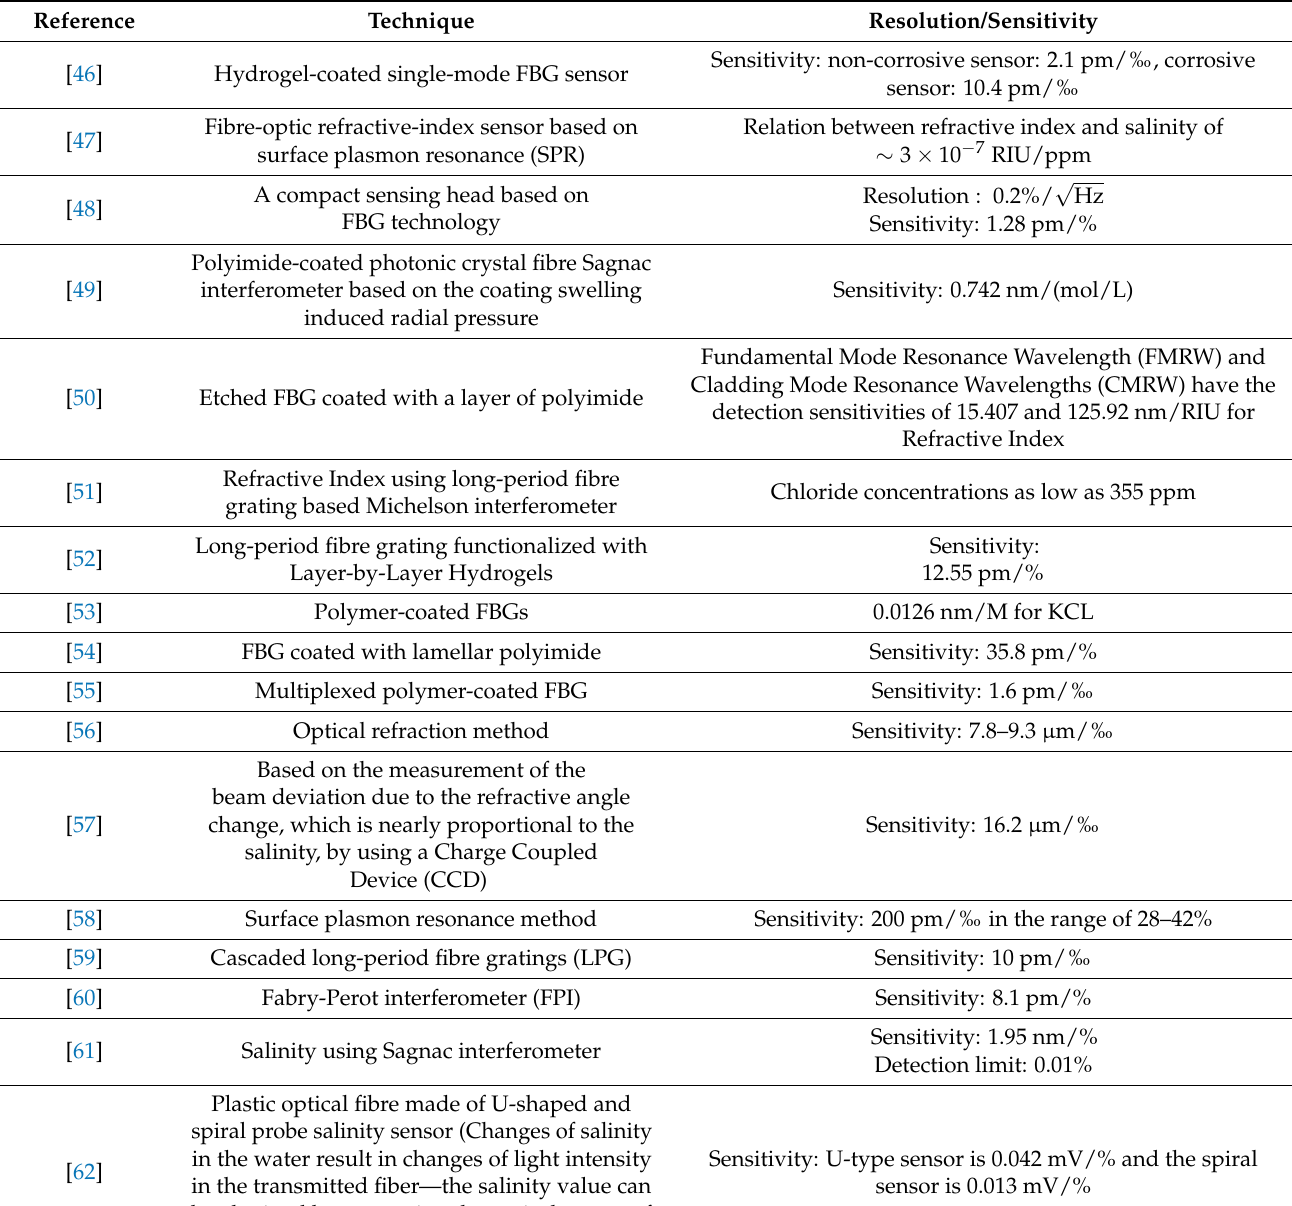
Table 6. Comparison of different optical fibre methods for salinity